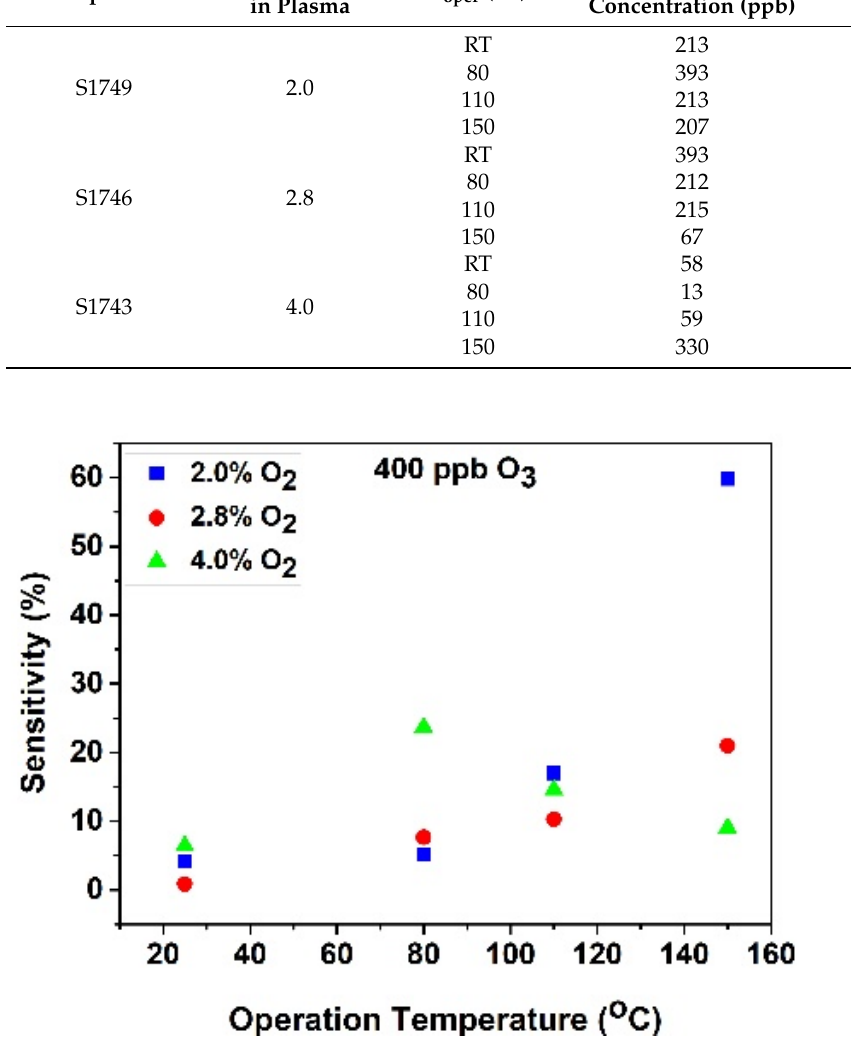
Figure 6. Sensitivity on different ozone concentrations at various operating temperatures of rf- sputtered NiO:Al with ( a ) 2.0%, ( b ) 2.8%, and ( c ) 4.0% O 2 in plasma. A linear fitting plot has been Table 2. Deposition parameters, temperature of operation ( ◦ C), minimum detection concentration applied. (ppb), and sensitivity (S) of rf-sputtered Al-doped NiO films. Sample No.